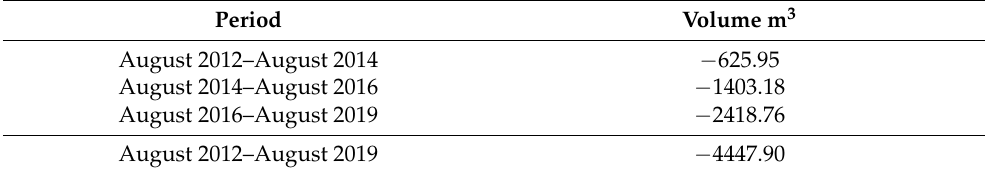
Table 3. Calculation of the volume loss of the rock glacier using data from the